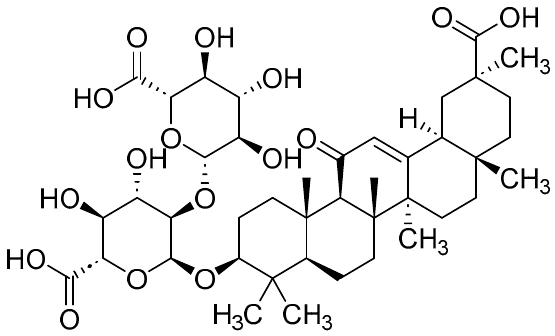
Figure 2. Structure of glycyrrhizic acid, a naturally occurring inhibitor of RAGE acting as HMGB1 antagonist.